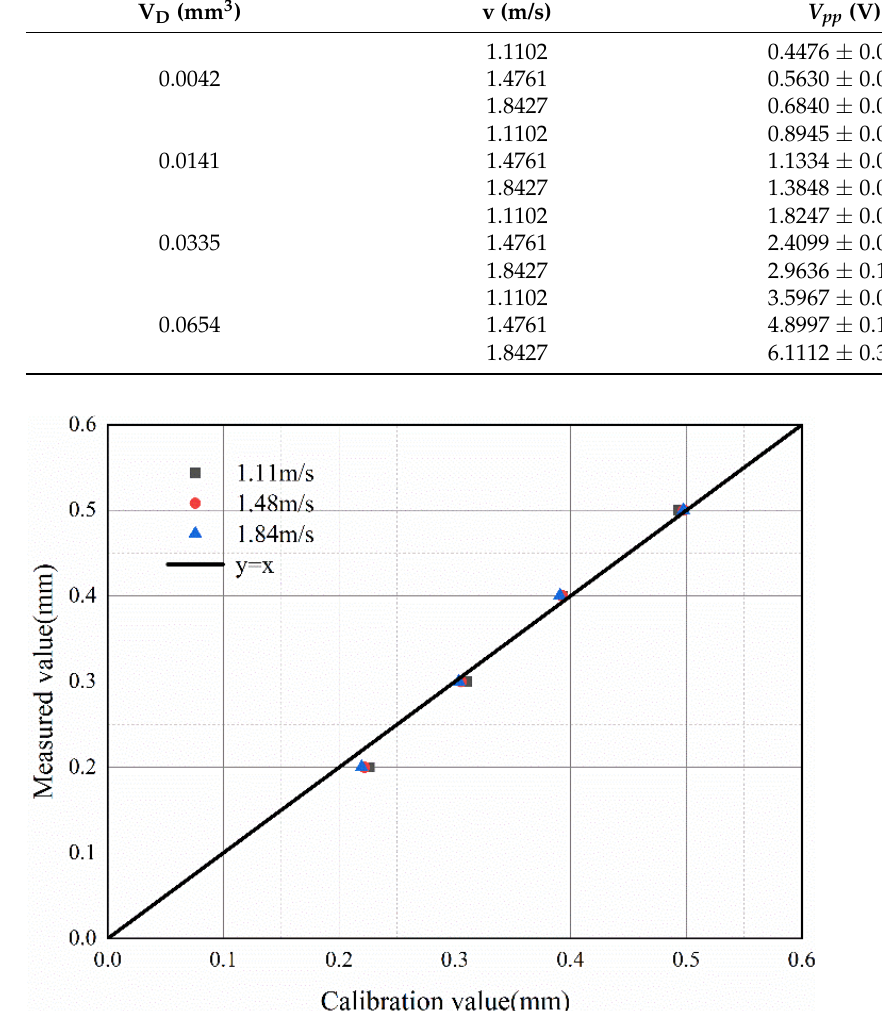
Figure 16. Comparison of experimental value and theoretical value.